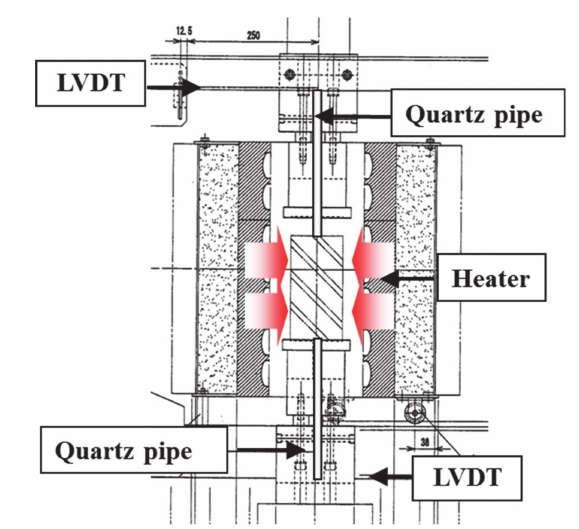
Figure 4. Schematic representation of the heating method.